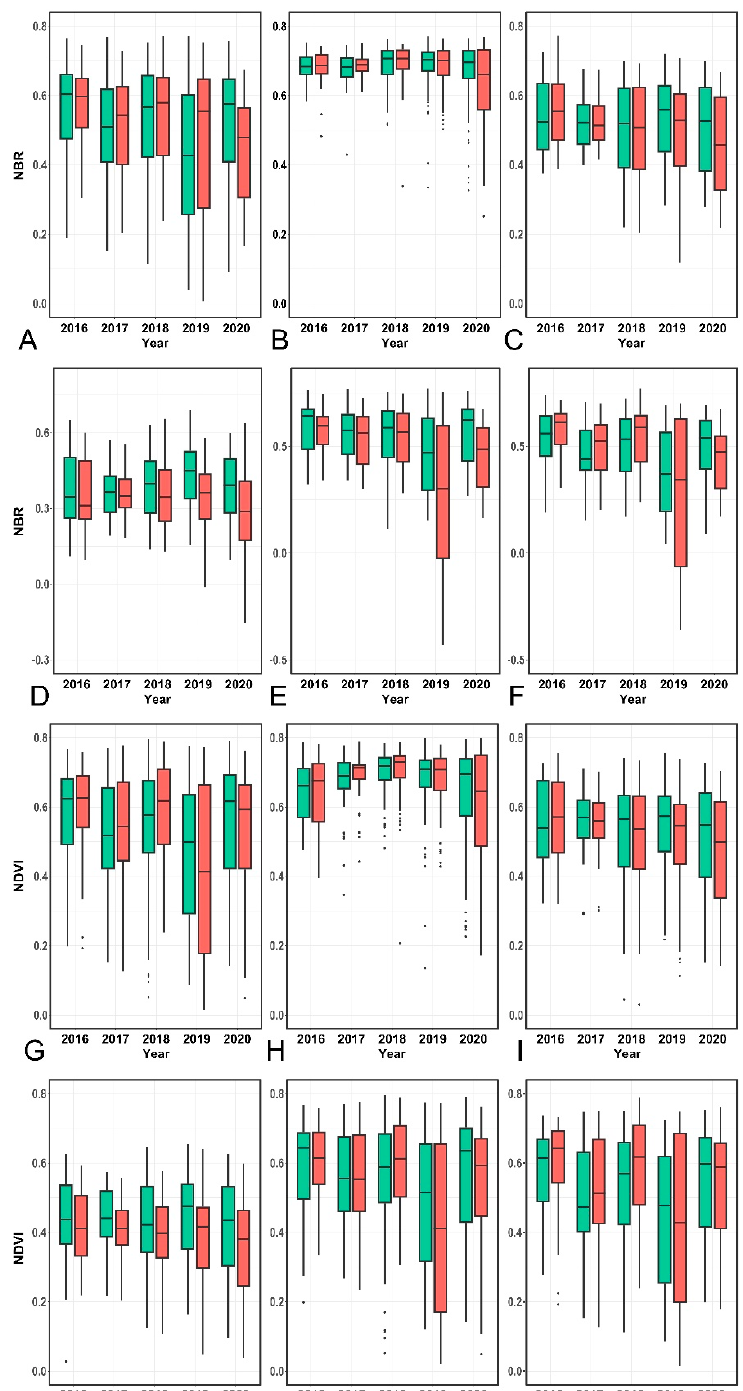
Figure 4. Boxplots of unburned (green) and burned (red) areas. Average annual maximal and minimal thresholds of spectral indices for NBR at Alta Vista (( A ), forest), Copaibo (( B ), forest), Laguna Marfil (( C ), forest; ( D ), nonforest) and Ñembi Guasu (( E ), forest; ( F ), nonforest). Average annual maximal and minimal thresholds of spectral indices for NDVI at Alta Vista (( G ), forest), Copaibo (( H ), forest), Laguna Marfil (( I ), forest; ( J ), nonforest) and Ñembi Guasu (( K ), forest; ( L ), nonforest). Box plot elements: box = values of 25th and 75th percentiles; horizontal line = median; whiskers = values of 5th and 95th